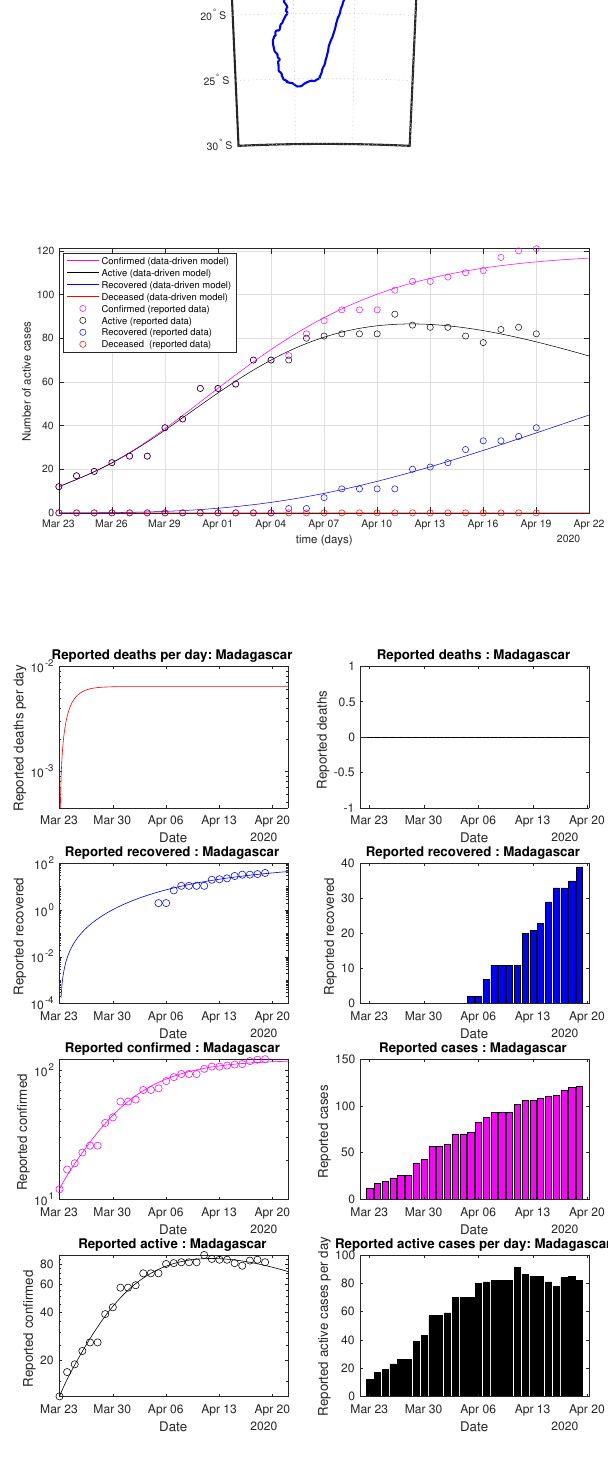
Figure 70. Madagascar: data vs.